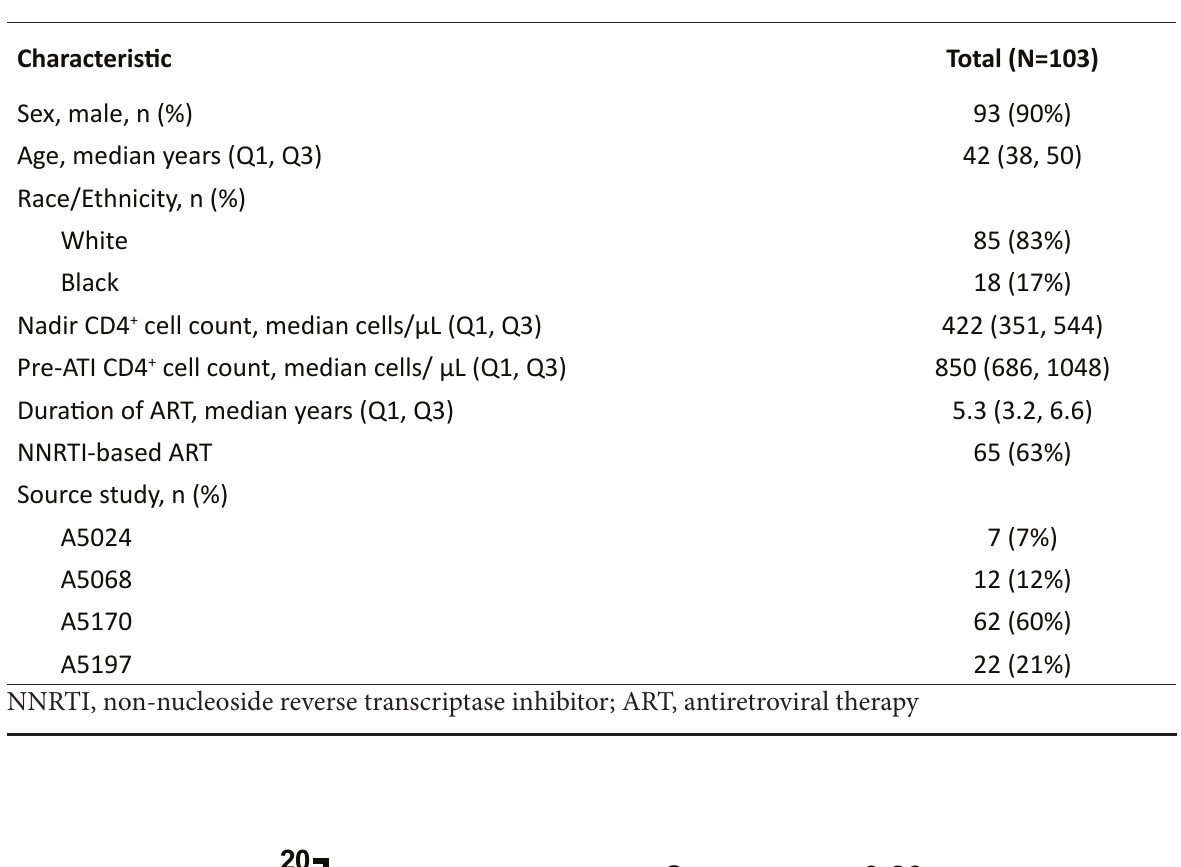
Table 1. Baseline characteristics of participants included in the study.